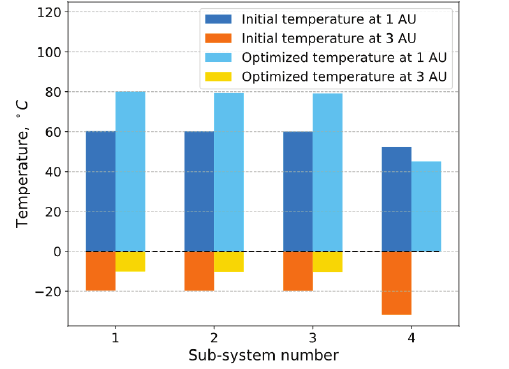
Figure 8. Initial and optimized temperatures. Sub-system 4 temperature at 3 AU aft er optimization is zero